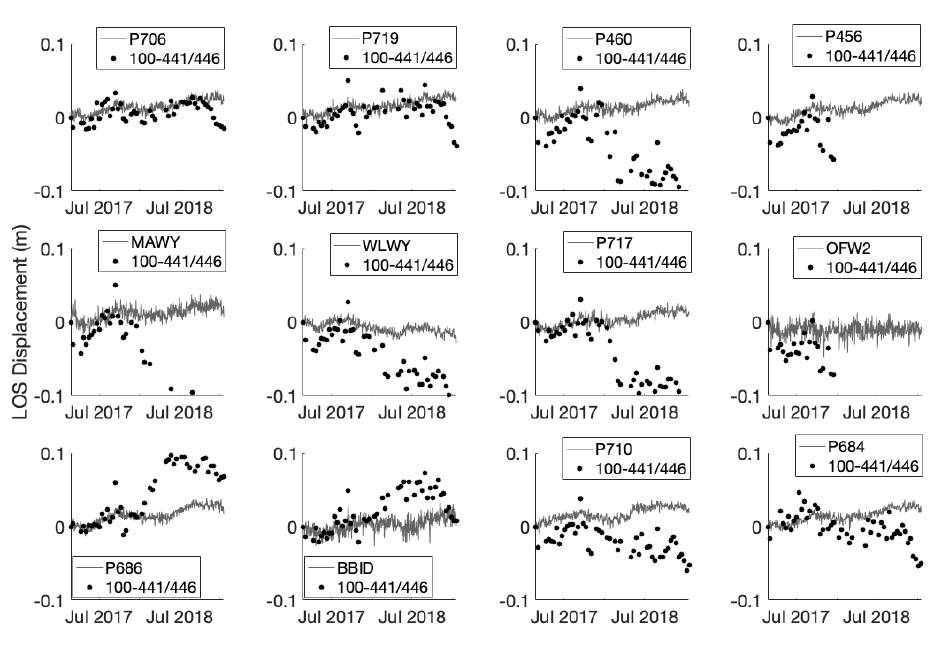
Figure 13. Comparison of GNSS displacement with displacement derived from the corresponding DInSAR pixel in the 100-441/446 frame. The displacements are shown in the LOS direction of the DInSAR data